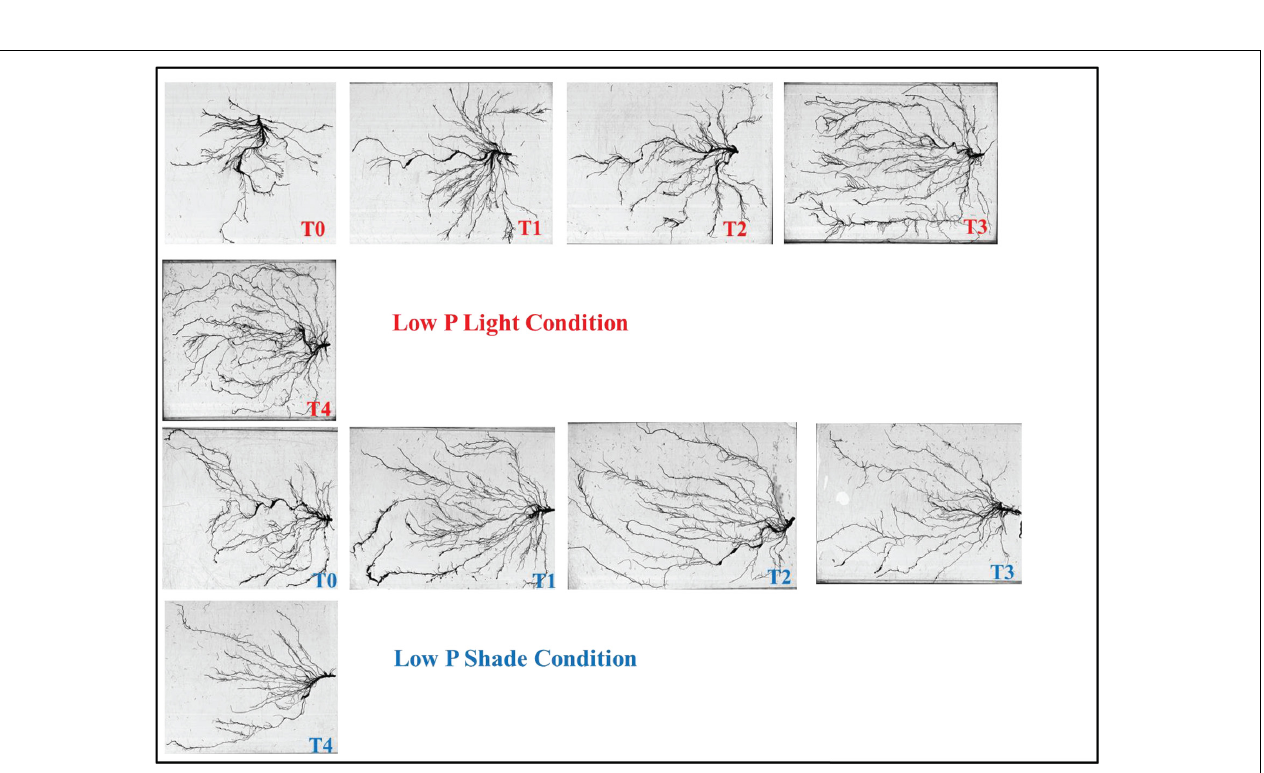
FIGURE 9 | Effect of Ti application on root morphology of the soybean under NL and SC combined with LP conditions.